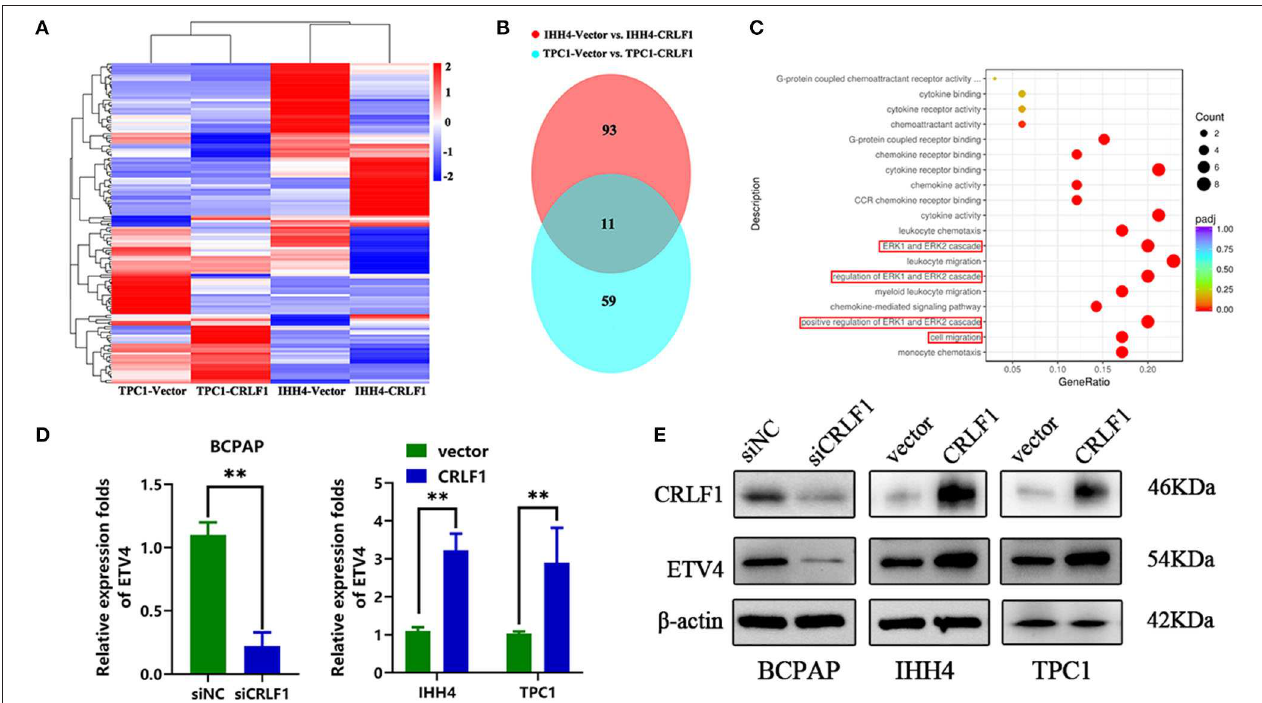
FIGURE 4 | ETV4 is the downstream target gene of CRLF1 in PTC. (A) After CRLF1 overexpression, the downstream mRNA sequence was analyzed. (B) A Venn diagram showing 11 co-altered genes in the two groups of PTC cells. (C) Bioinformatic analysis showing a significant association between ERK pathway and cell migration after CRLF1 overexpression. (D) The mRNA expression level of ETV4 after CRLF1 knockdown or overexpression in PTC cells as measured by qPCR analysis. (E) The protein expression level of ETV4 after CRLF1 knockdown or overexpression in PTC cells as measured by Western blot assay. β -Actin served as internal reference gene for the qPCR assays and as a loading control for the Western blot assays. Data are presented as the mean ± SD. Significant differences are indicated: ** P <